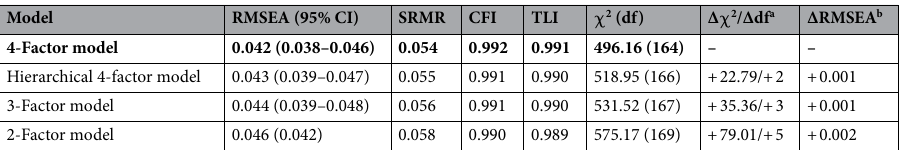
Table 2. Model fit indices for all assessed nested structural models of the APQ. The model with the best fit is shown in bold. N = 1153. RMSEA, root mean square error of approximation; CI, confidence interval; SRMR, standardized root mean squared residual; CFI, Comparative Fit Index; TFI, Tucker-Lewis Fit Index; χ 2 , Chi- square; df, degrees of freedom. a Likelihood ratio test, shown as a change in χ 2 /df values relative to the parent model i.e. the hypothesized 4-factor model (top row). b Change in RMSEA value relative to the parent model i.e. the hypothesized 4-factor model (top